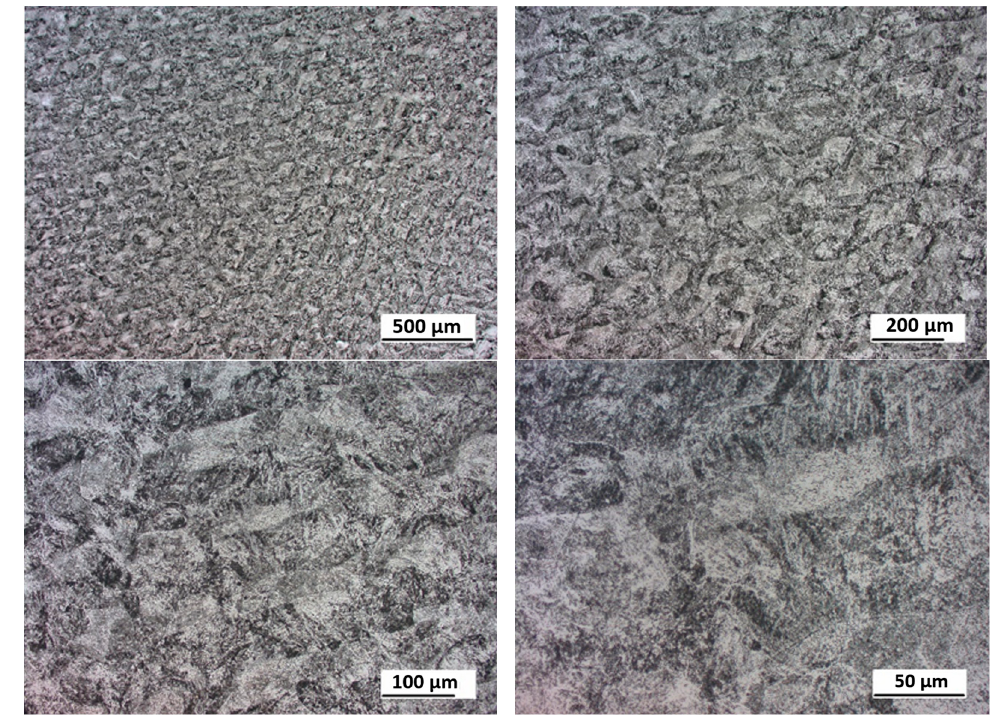
Figure 5. Microstructure of the 3D-printed specimens under different magnifications.